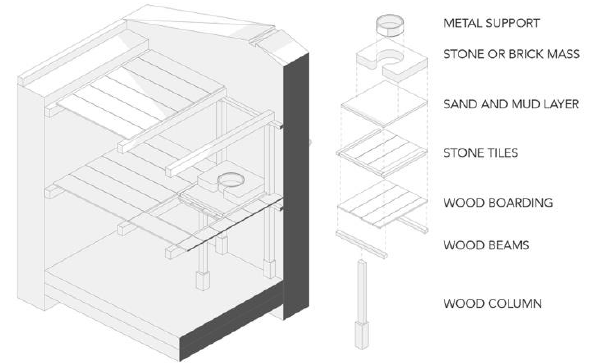
Figure 20. Axonometric stove section